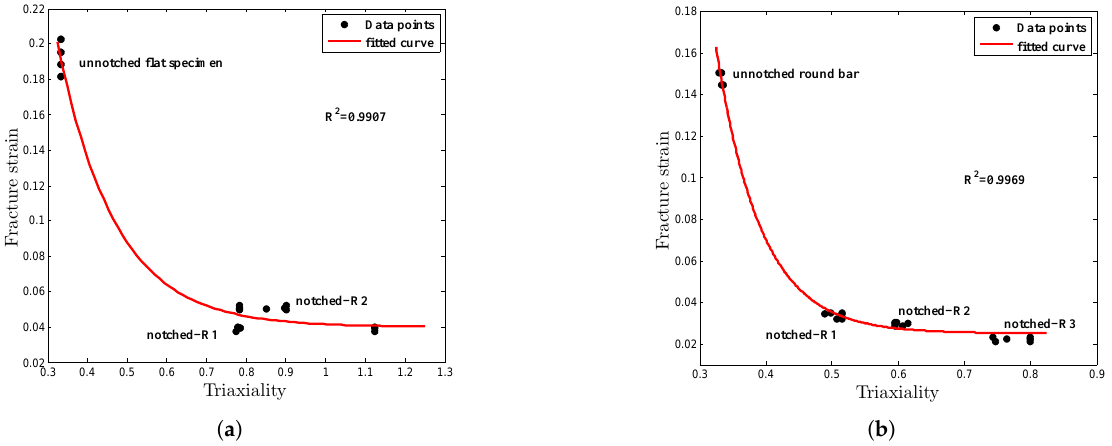
Figure 10. Relationship plot of strain to fracture and stress triaxiality. ( a ) Flat specimens; ( b ) Round bar